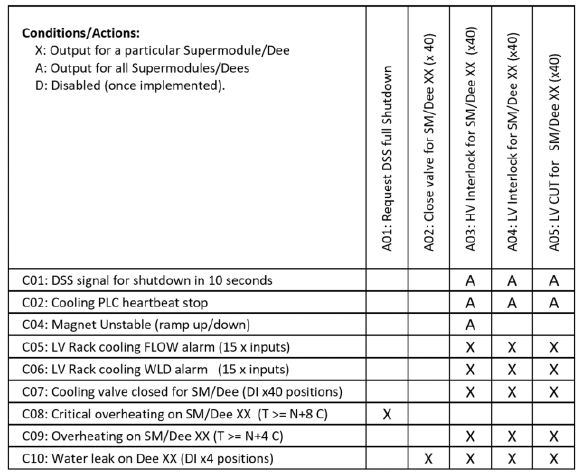
Fig. 2. Simplified version of the ESS action